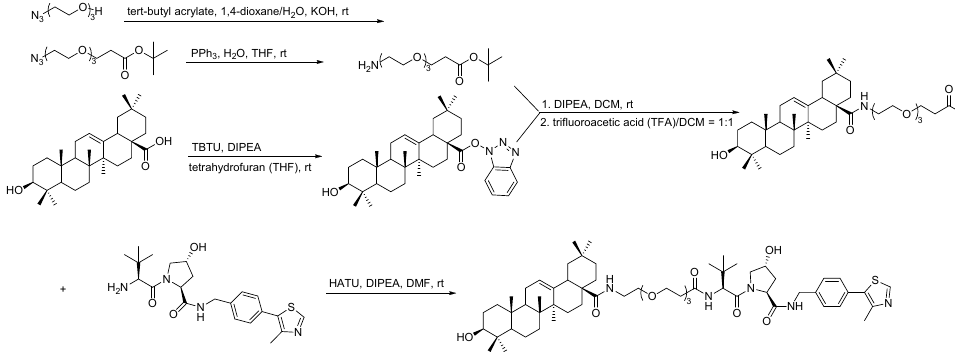
Scheme 11. Synthesis of oleanolic-acid–based PROTAC.